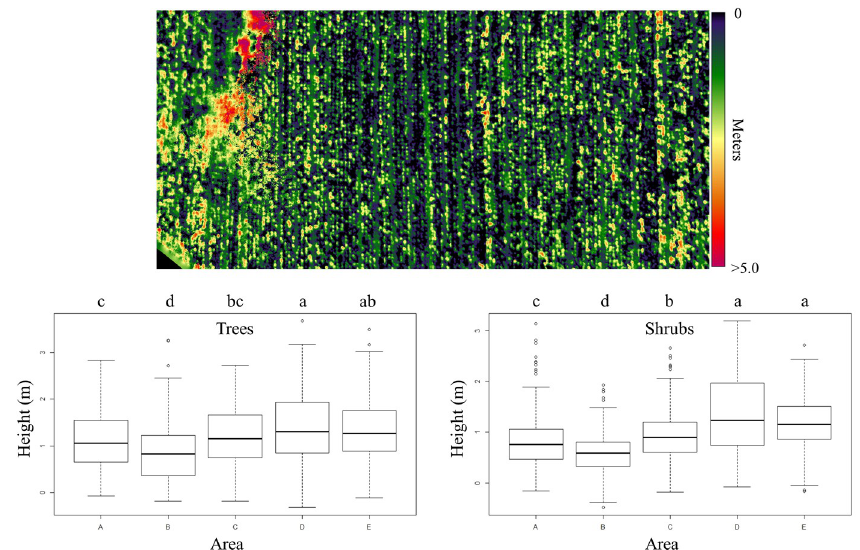
Figure 6. Canopy height model (CHM) of the study area and the heights of the tree and shrub classes at different locations (Areas A–E). The small letters at the top of the box plot indicate the differences in tree heights (computed by the Tukey HSD method ( p < 0.05)).